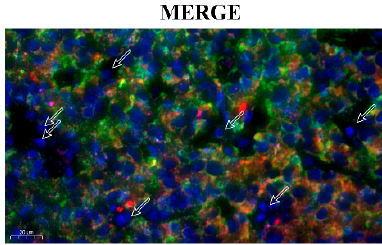
Figure 1. Mat2a was co-expressed with melatonin synthesis gene. ( A ) Relative expression of aanat, asmt and mat2a mRNA in RNA-seq and RT-qPCR results during the day and night. ( B ) Relative expression of AANAT, ASMT and MAT2A proteins in pineal gland during the day and night. ( C ) Relative expression of melatonin and S-adenosine methionine (SAM) in rat serum during the day and night. ( D ) Immunofluorescence colocalization of AANAT (green), ASMT (pink) and MAT2A (red) in rat pineal gland. Arrows indicate areas of low gene expression with a scale of 20 µm. *, p < 0.05.